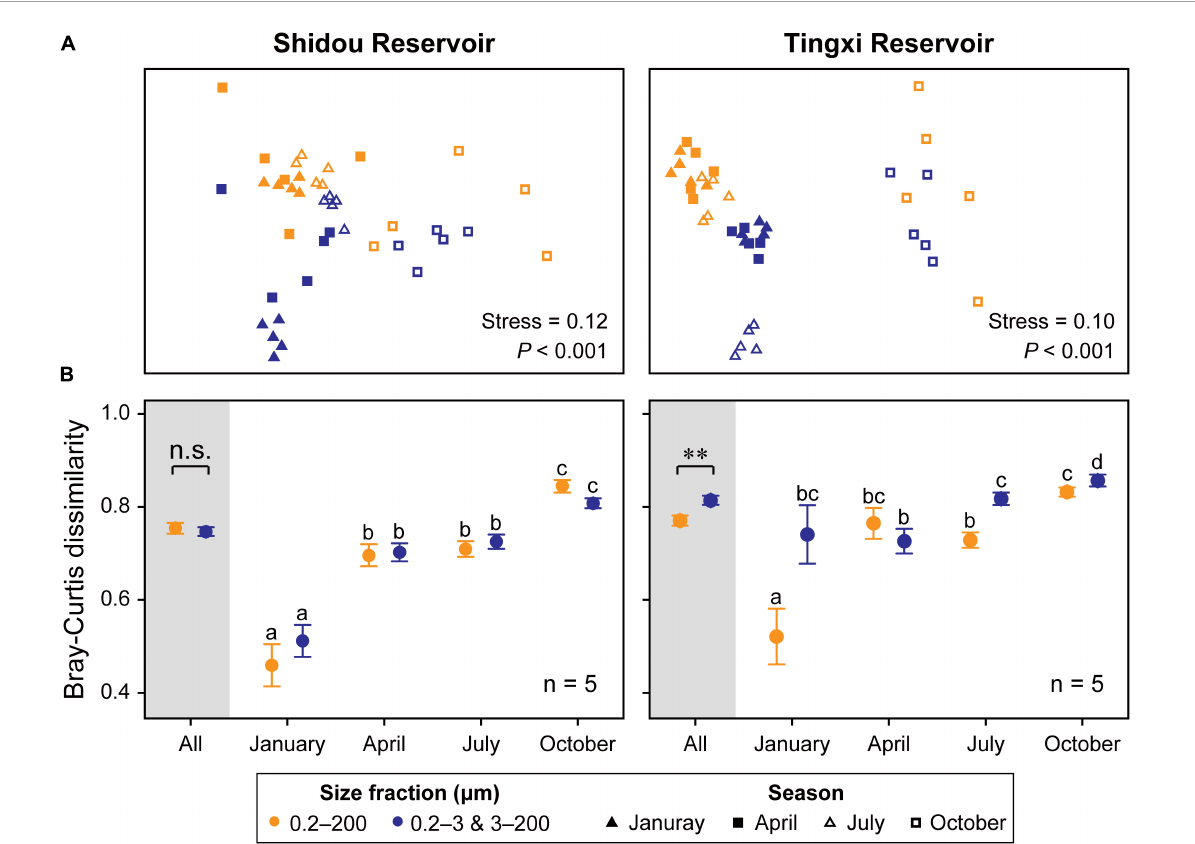
FIGURE6 Non-metric multidimensional scaling (NMDS) ordination of eukaryotic plankton communities between two size fractions (Color) and across four seasons (Shape) in both reservoirs (Global R of size fractions is 0.150 and 0.214, while that of seasons is 0.514 and 0.545, respectively, in the Shidou and Tingxi reservoirs) (A) . Pairwise Bray–Curtis dissimilarity of different size-fractionated eukaryotic plankton communities. Data are mean ± standard error (SE), and the error bar represents the standard error along with five water layers (n = 5). Significant differences ( P < 0.05) within-group are indicated with different letters by the non-parametric Mann–Whitney U test (B) . The small letters are used to distinguish whether there are statistical differences between the two filtering treatments (0.2–200 µ m vs. 0.2–3 and 3–200 µ m) in different seasons (January, April, July, and October). There is no significant difference between groups marked with the same letter, but there is a significant difference between groups marked with different